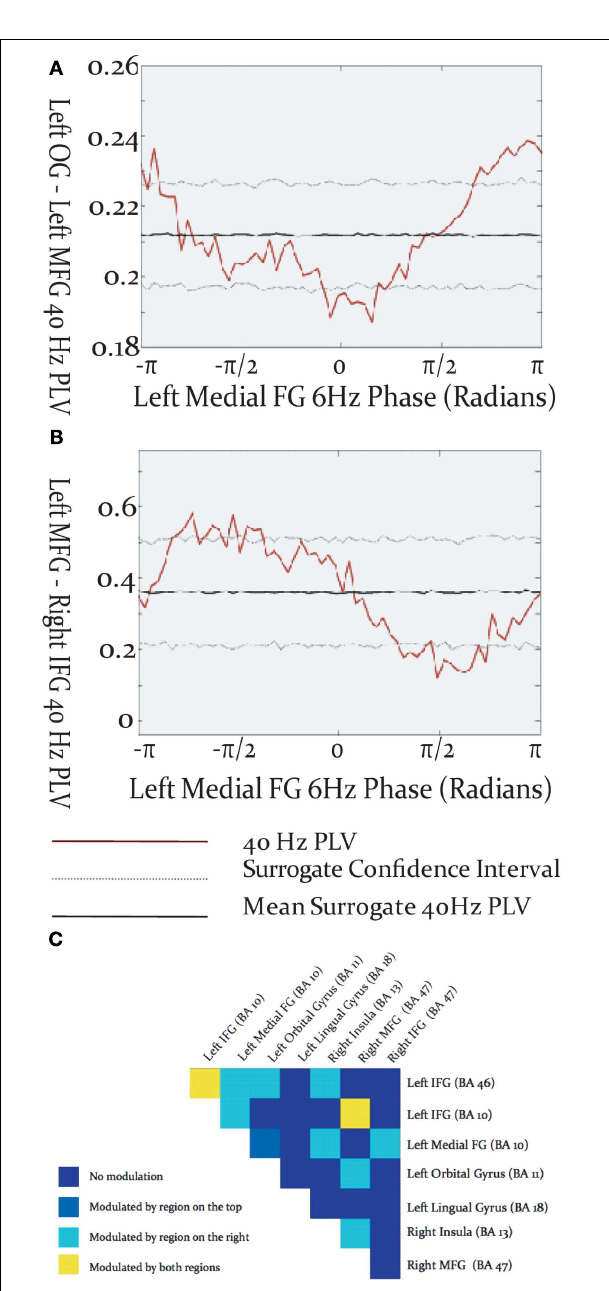
FIGURE 4 | Modulation of inter-regional gamma-band synchronization by theta phase within the activated network. (A,B) Examples of cross-frequency modulation of inter-regional synchrony. (C) Theta modulation of inter-regional gamma synchronization throughout the activated network. Each box represents a region pair, listed at lop and right, and colors reflect whether gamma-band phase locking was modulated by theta phase in one, both, or neither of the